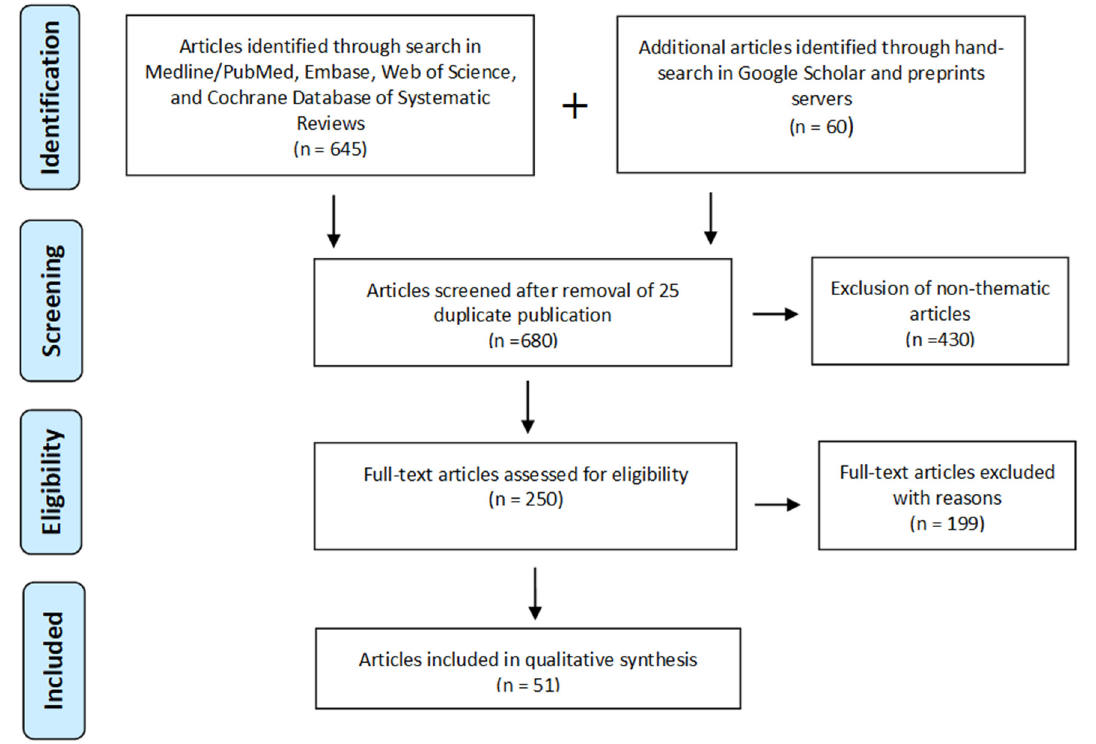
Figure 1. Flow-chart diagram of the literature search on pedobarographic